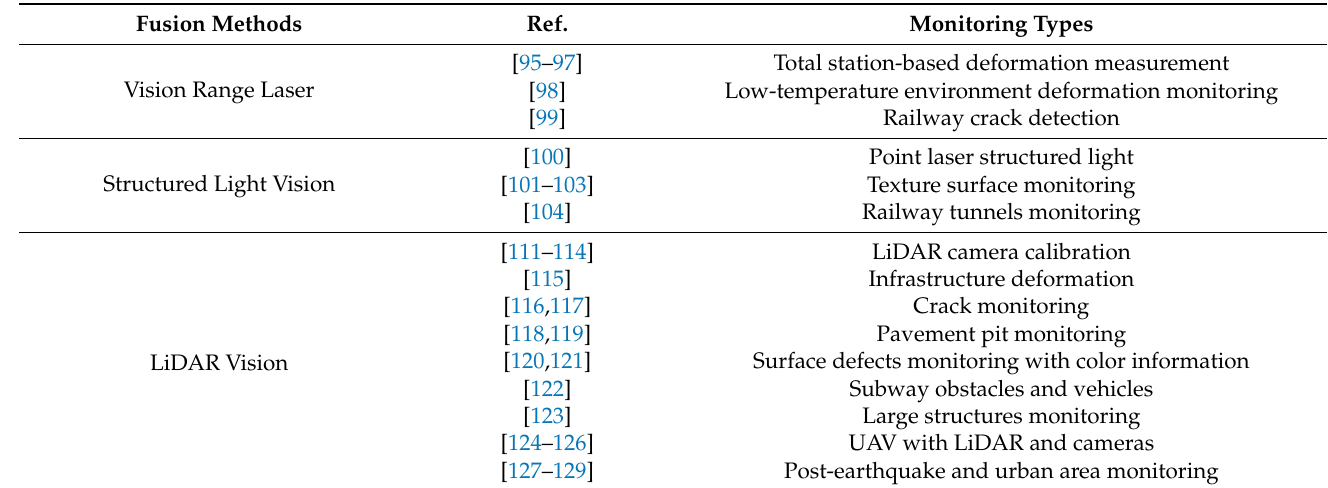
Table 5. Summary of vision–laser-based infrastructure